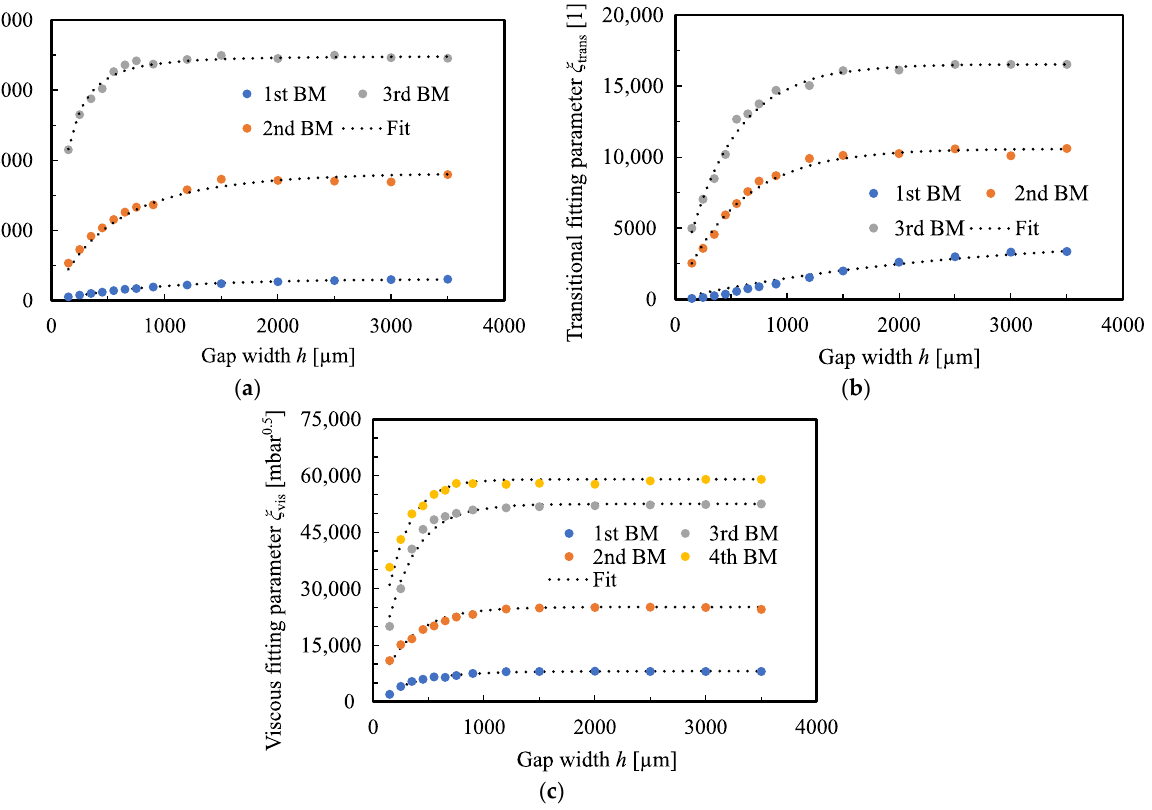
Figure 6. The determined fit parameters for MEMS oscillator BO3 of the higher bending modes as a function of the gap width. In ( a ) the curve is shown for the molecular fitting parameter, in ( b ) for the transitional fitting parameter, and in ( c ) for the viscous fitting parameter. Each plot was fitted by an upward limited exponential growth function to determine the characteristic length ( cf. Equa- tion (10)).